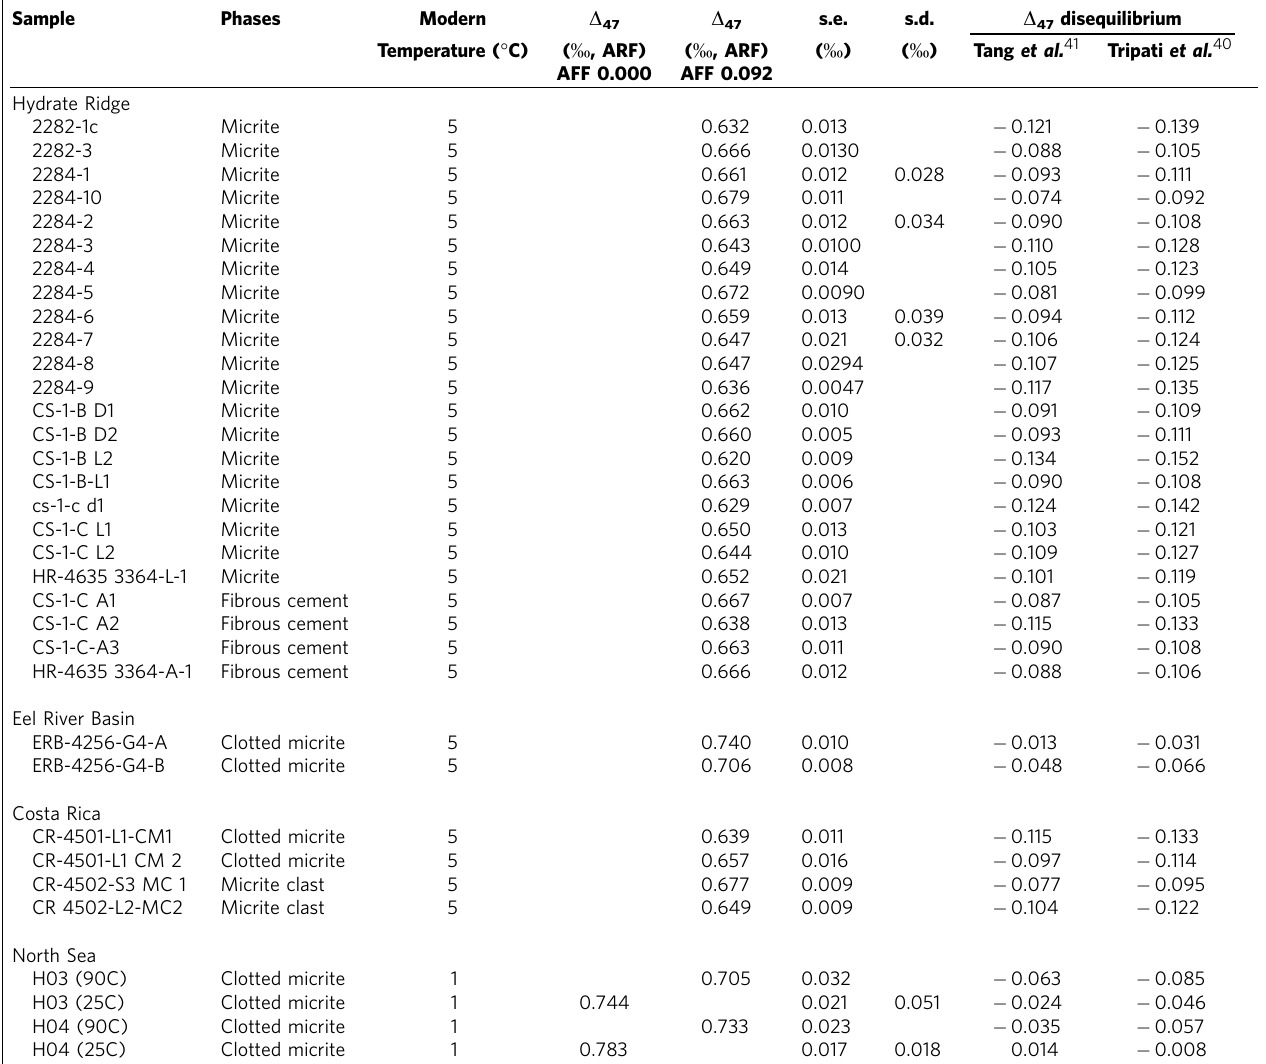
Table 3 | Degree of D 47 offset from values expected from bottom water temperatures.